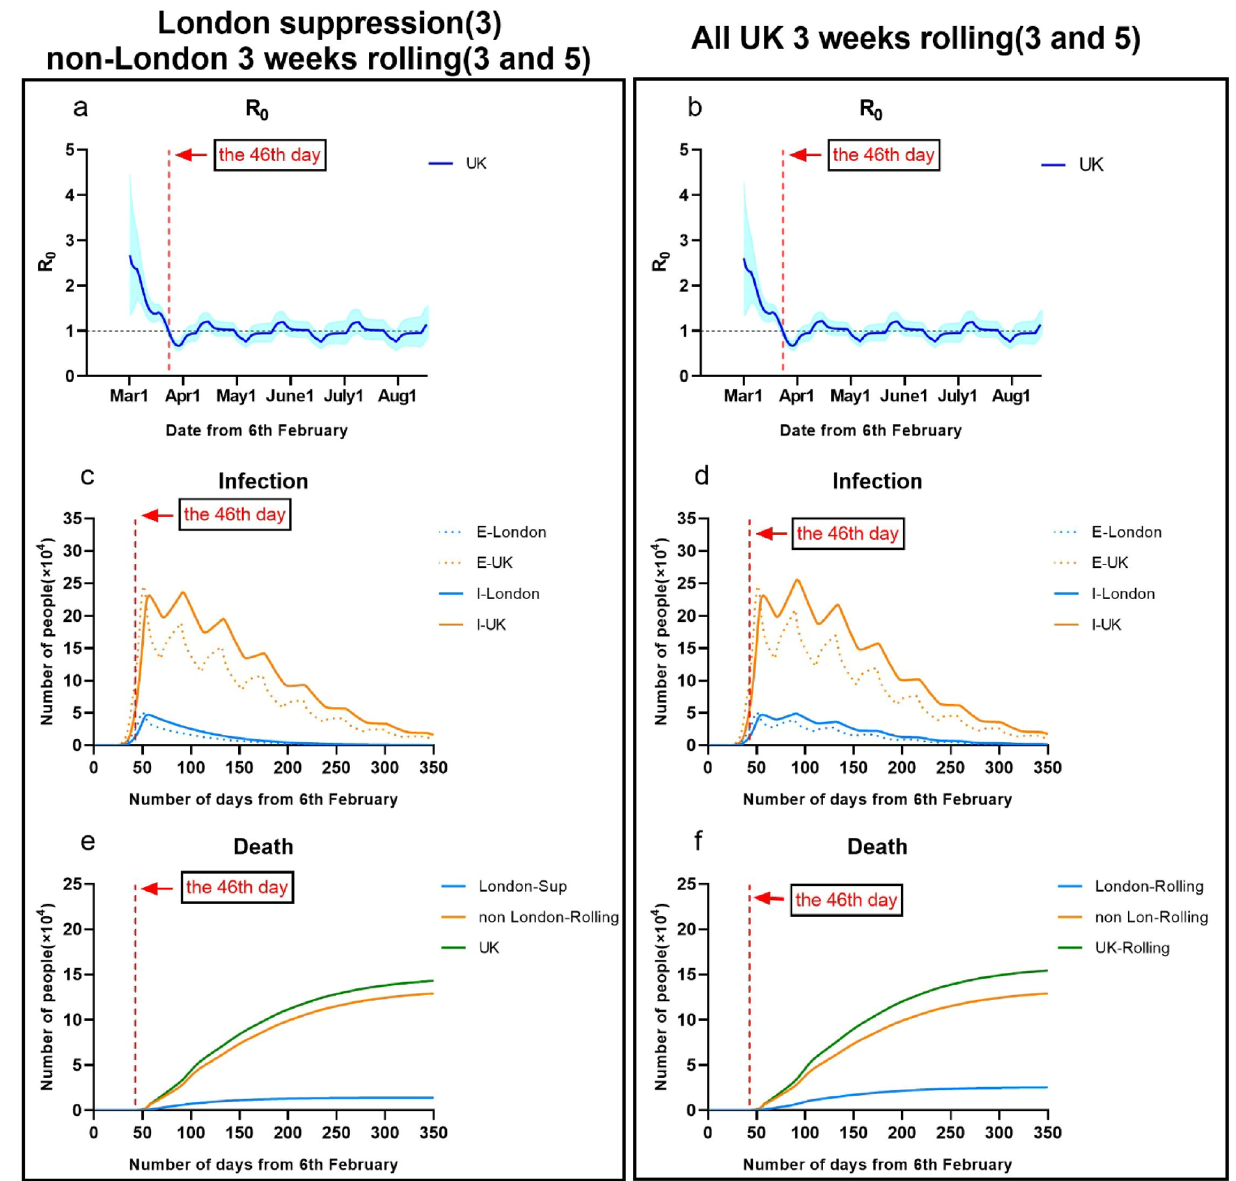
population: 57.2 million. ( b ) Suppression Intervention (M = 3), 3 weeks rolling intervention (M = 3–5-3–5, M = 3–4-3–4-3–4) ( E number of exposed, I number of